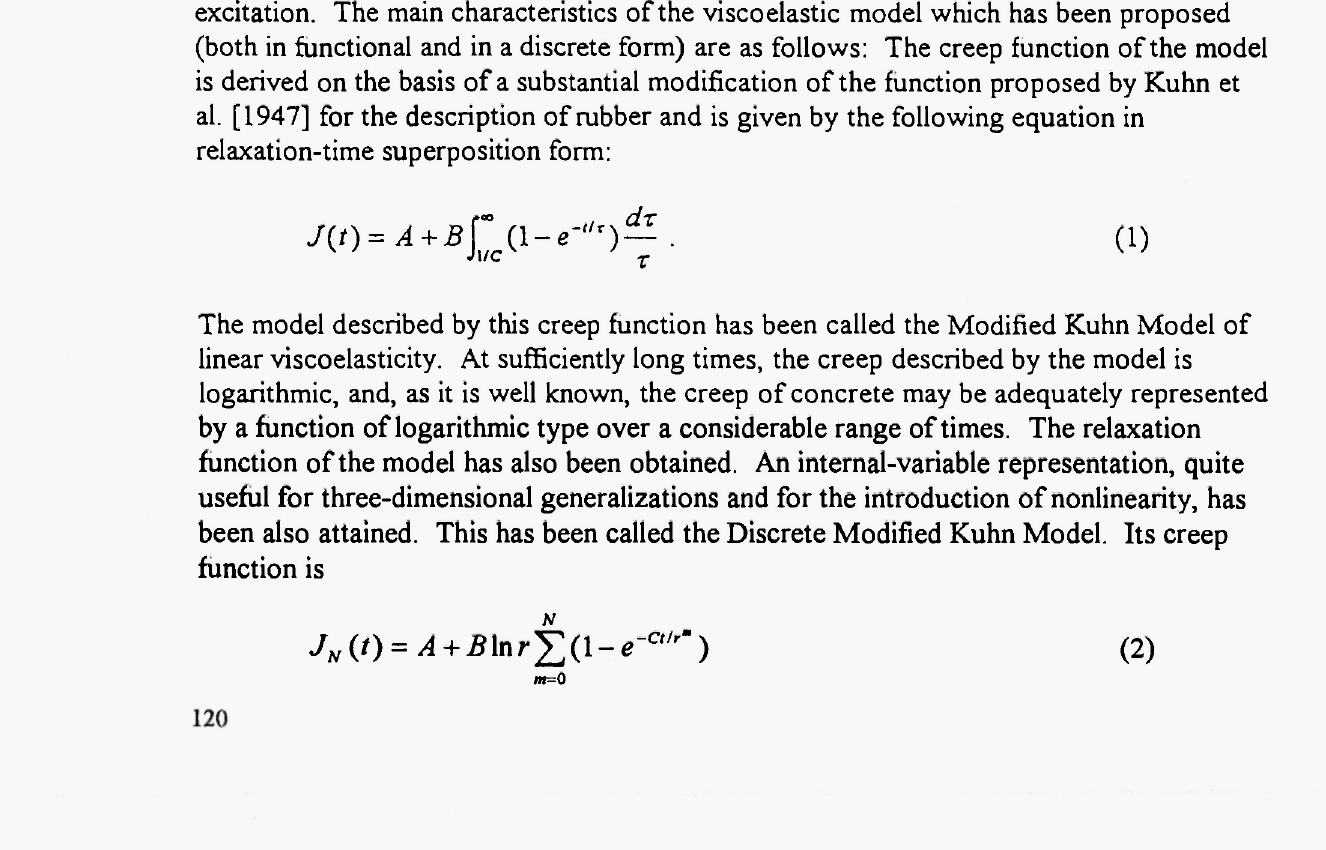
Figure 1. The Unified